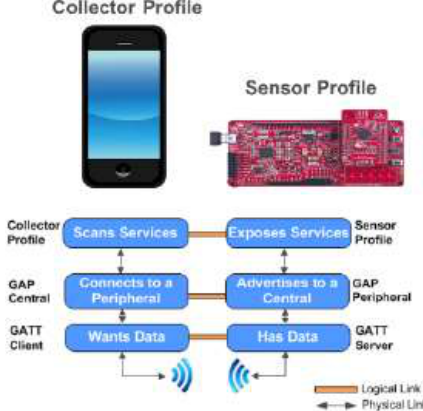
Figure 4. Overview of the Beacon/Collector